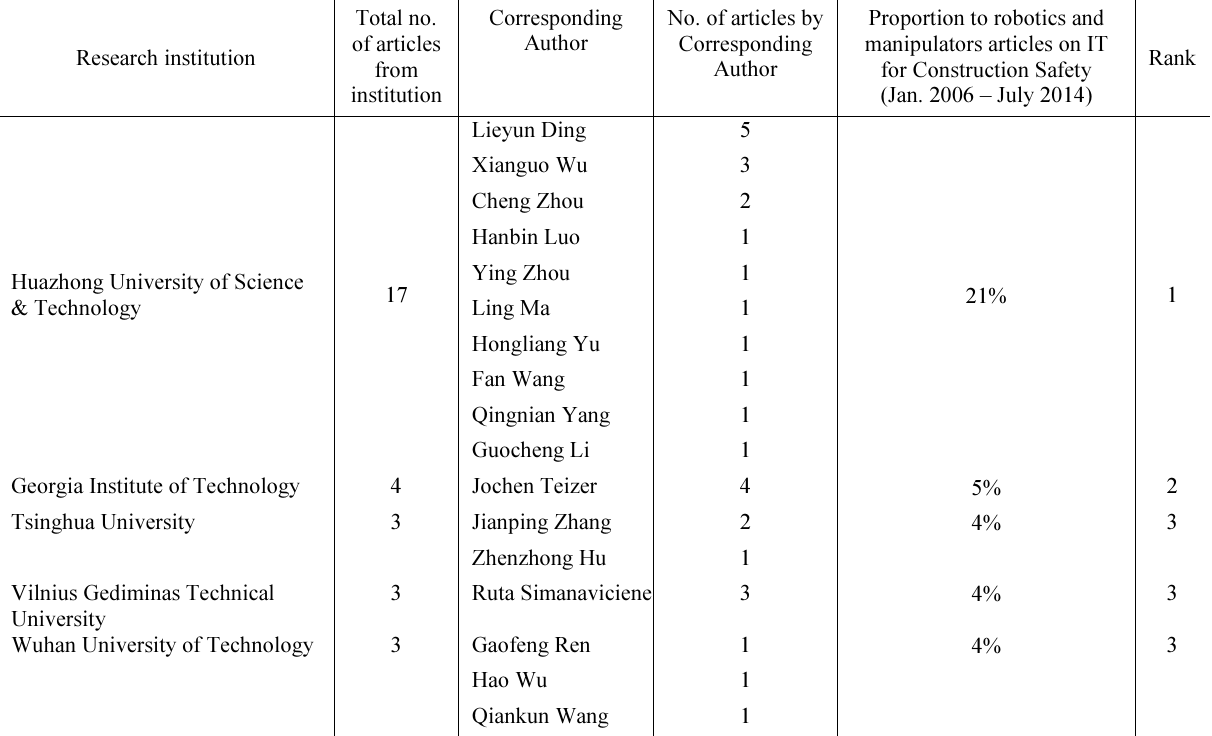
Table 7. Research institutions and corresponding authors on information analysis and reporting systems for construction safety